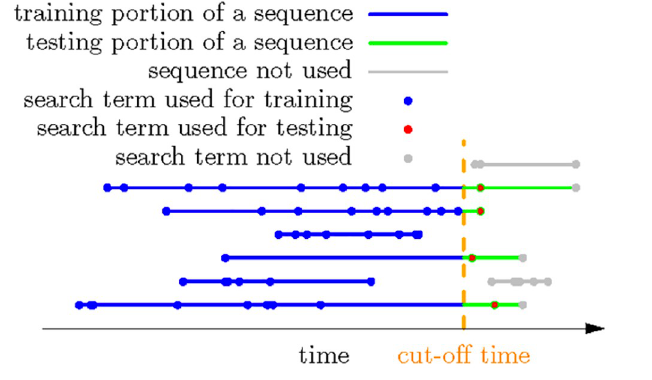
Fig 4. CUTOFF experimental